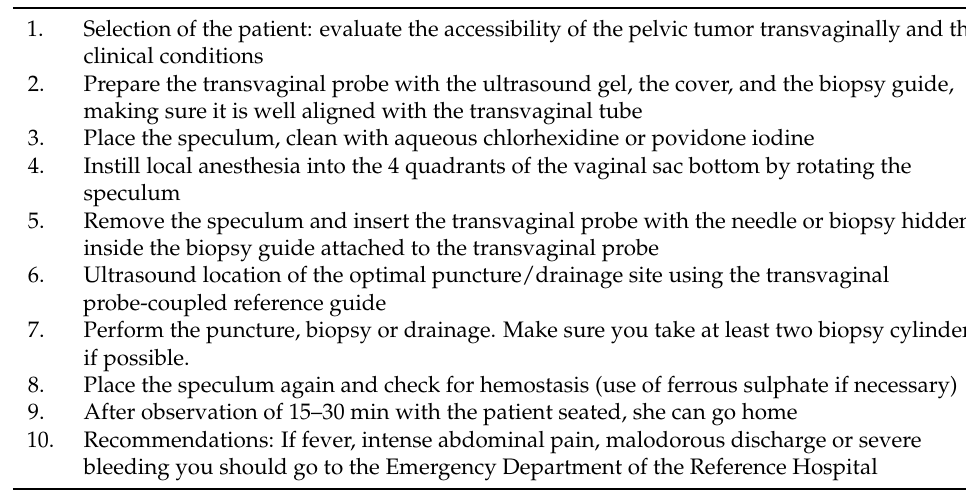
Table 2. Summary of steps to be taken for performing transvaginal echo-guided